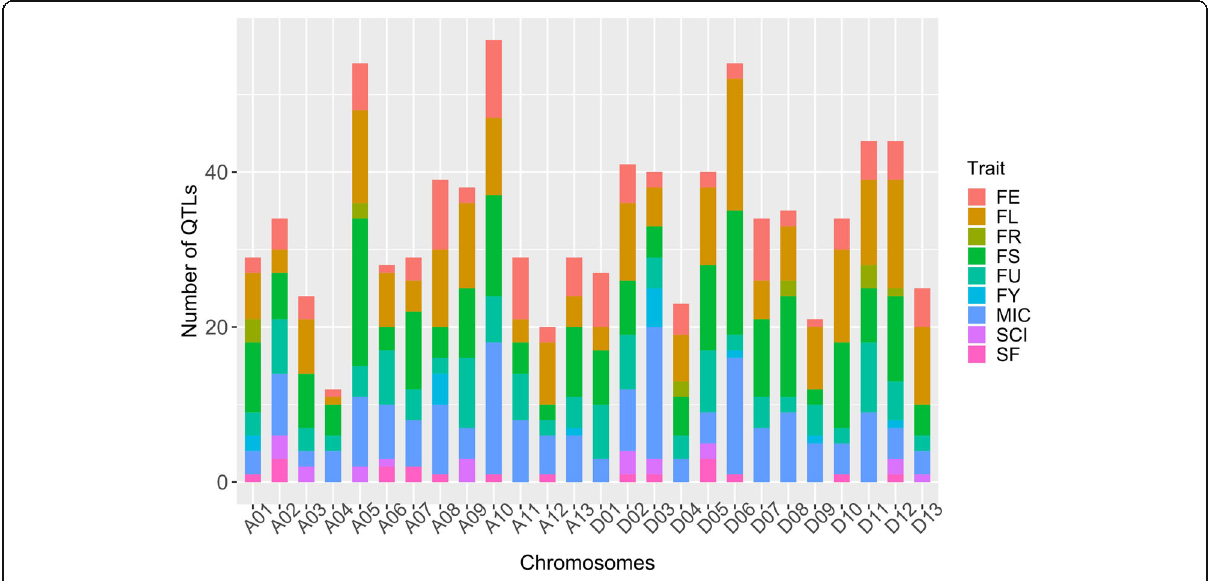
Fig. 1 Initial QTL distribution on 26 chromosomes of G. hirsutum genome. FL, fiber length; FS, fiber strength; MIC, micronaire; FU, fiber uniformity; FE, fiber elongation; SCI, spinning consistency index; SF, short fiber; FR, fiber reflectance; FY, fiber